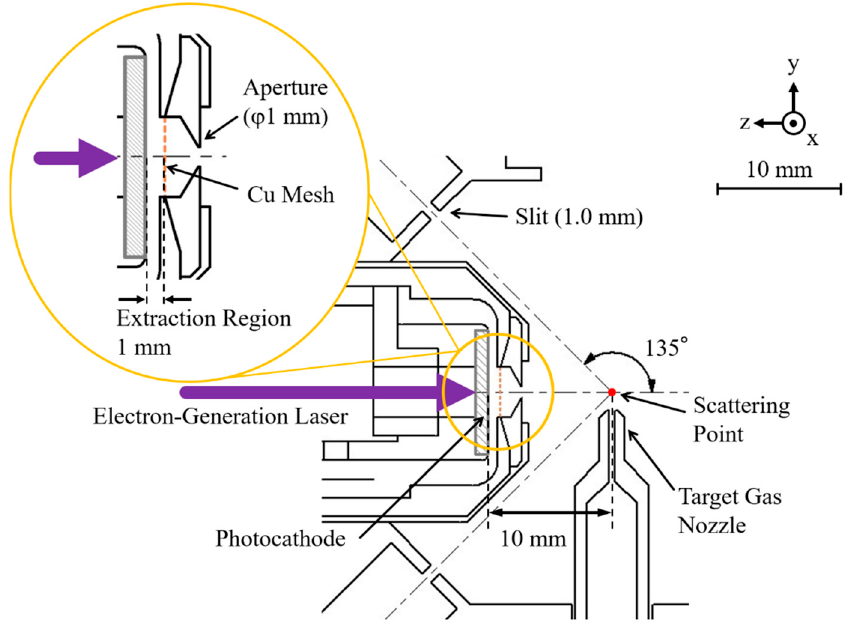
Figure 2. Schematic cross section of a pulsed electron gun, consisting of a back-illuminated photocathode, a copper electroformed mesh, and a collimating aperture. See text for details.